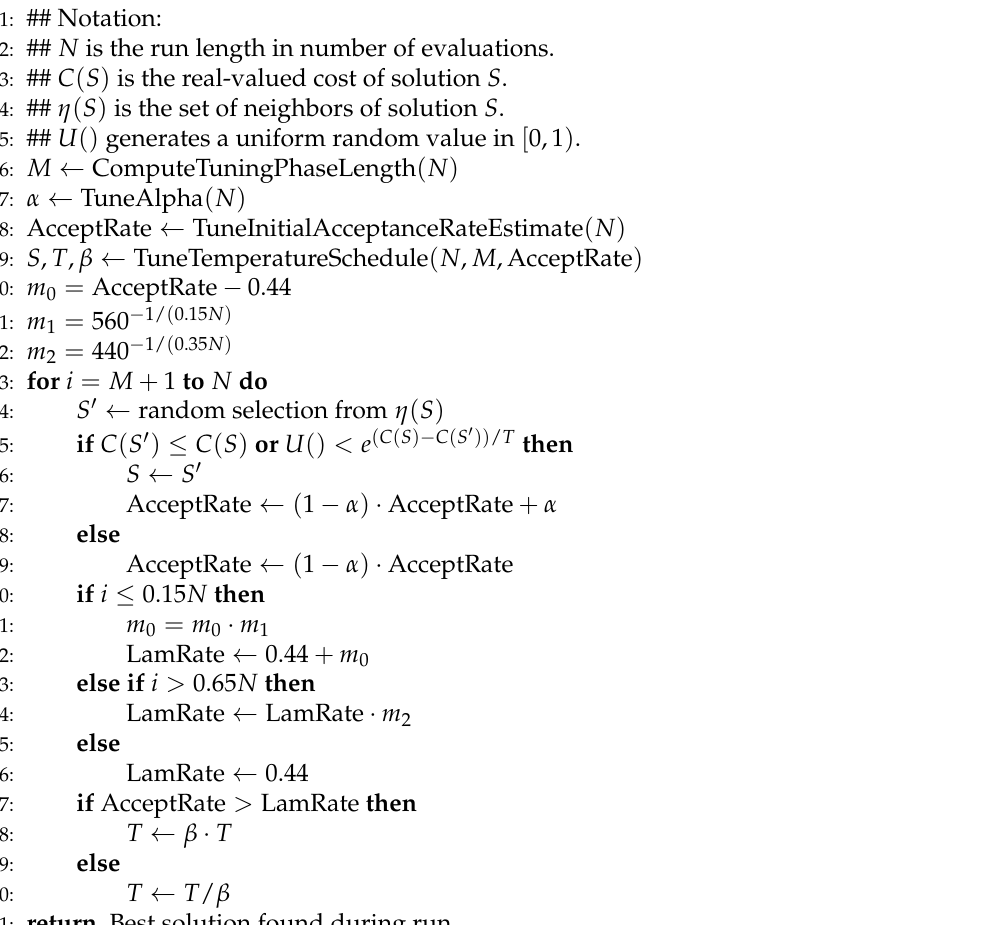
Algorithm 7 Self-Tuning Modified Lam